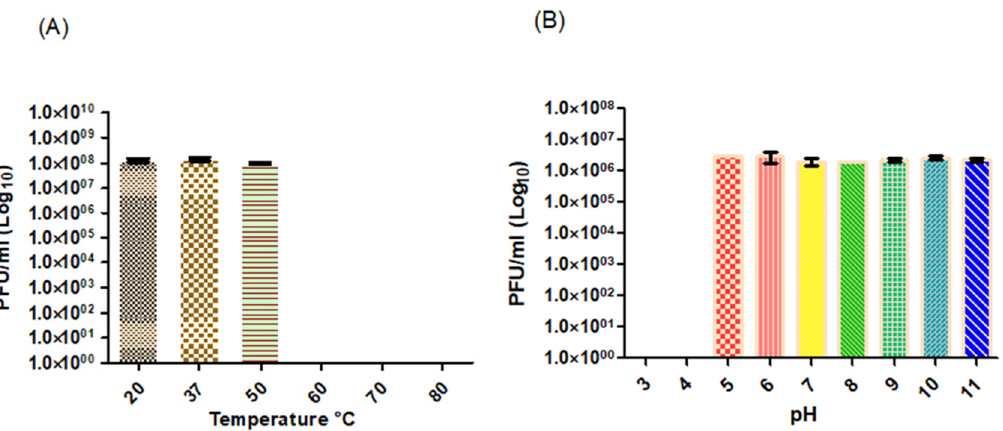
Figure 3. The effect of ( A ) temperature on phage stability, with no plaques detected >60 °C and ( B ) pH on phage stability, with no plaques detected at pH 3 and 4.